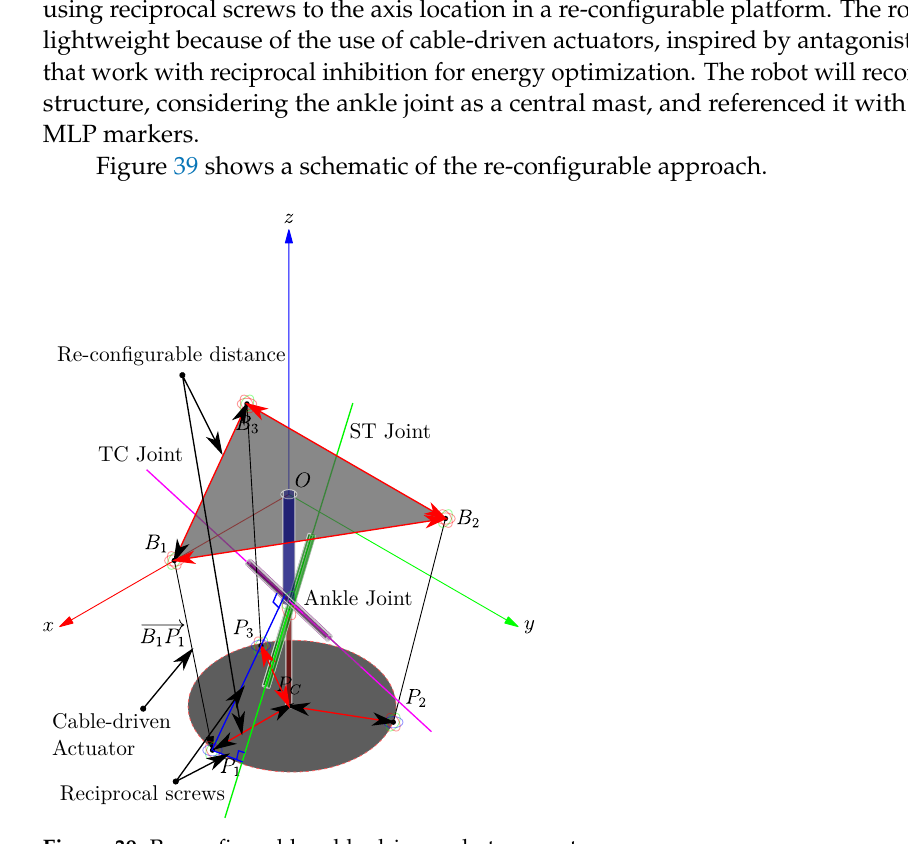
Figure 39. Re-configurable cable-driven robot